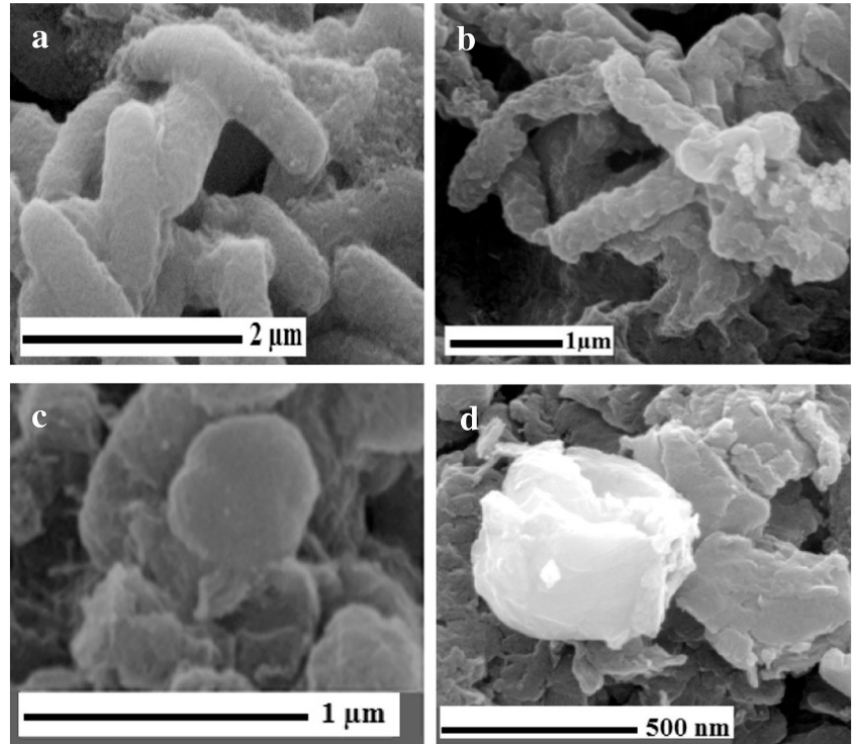
Figure 10. ( a ) SEM images of E. coli after incubation with saline solution for 2 h without graphene- based materials, ( b ) E. coli cells after incubation with GO-L 2 dispersion (40 µg/mL) for 2 h, ( c ) S. aureus after incubation with saline solution for 2 h without graphene-based materials, and ( d ) S. aureus cells after incubation with GO-L 2 dispersion (40 µg/mL) for 2 h [106].